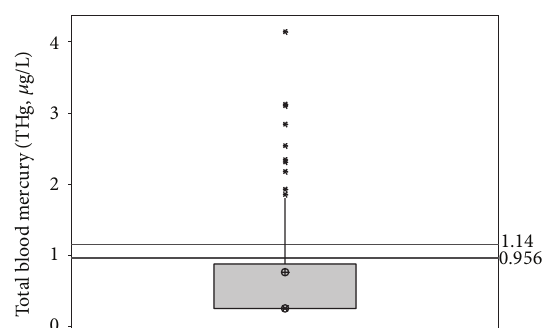
Figure 4: Scatterplot of total blood mercury (THg) for sample population with median denoted by an encircled “X” and mean denoted by an encircled cross. The reference lines at 0.956 𝜇 g/L and 1.14 𝜇 g/L indicate the 95% CI for THg in the US population from NHANES [36].